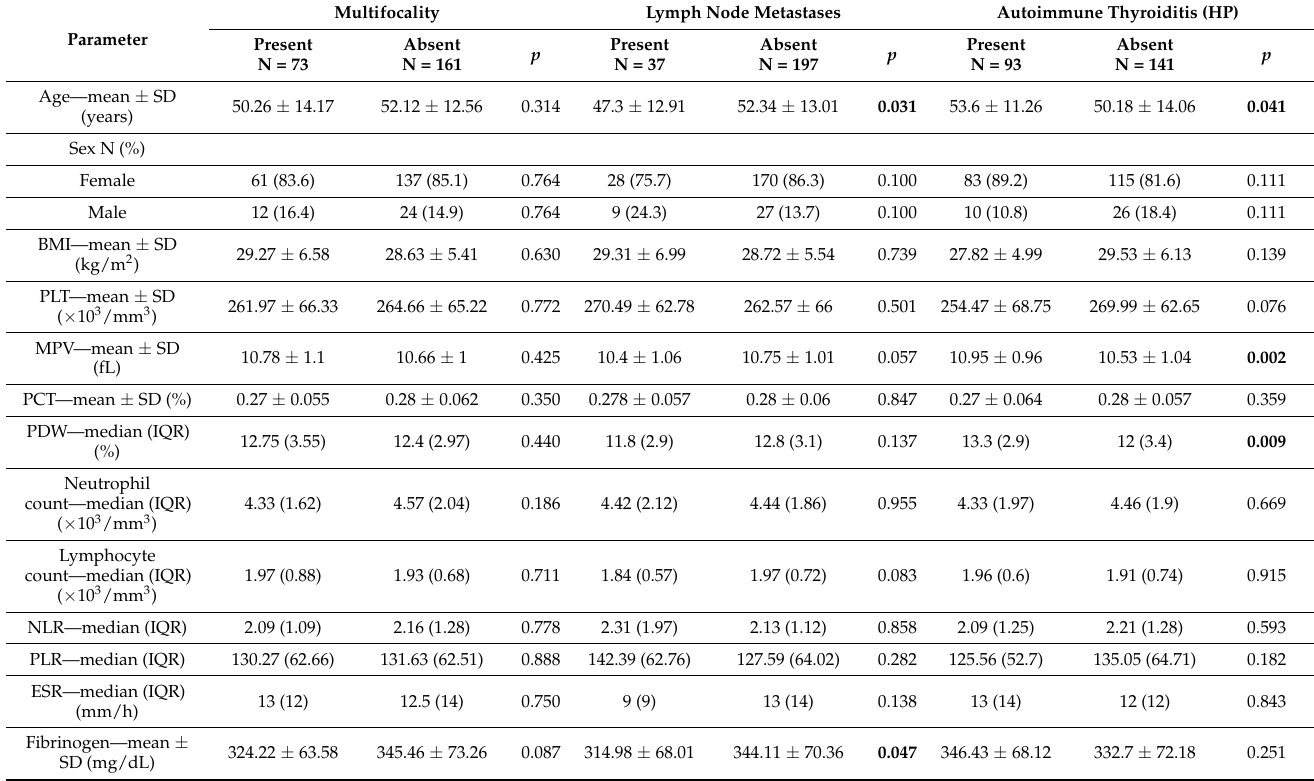
Table 5. Univariate comparative analysis of inflammatory markers and platelet indices according to pathological report characteristics in PTC patients.